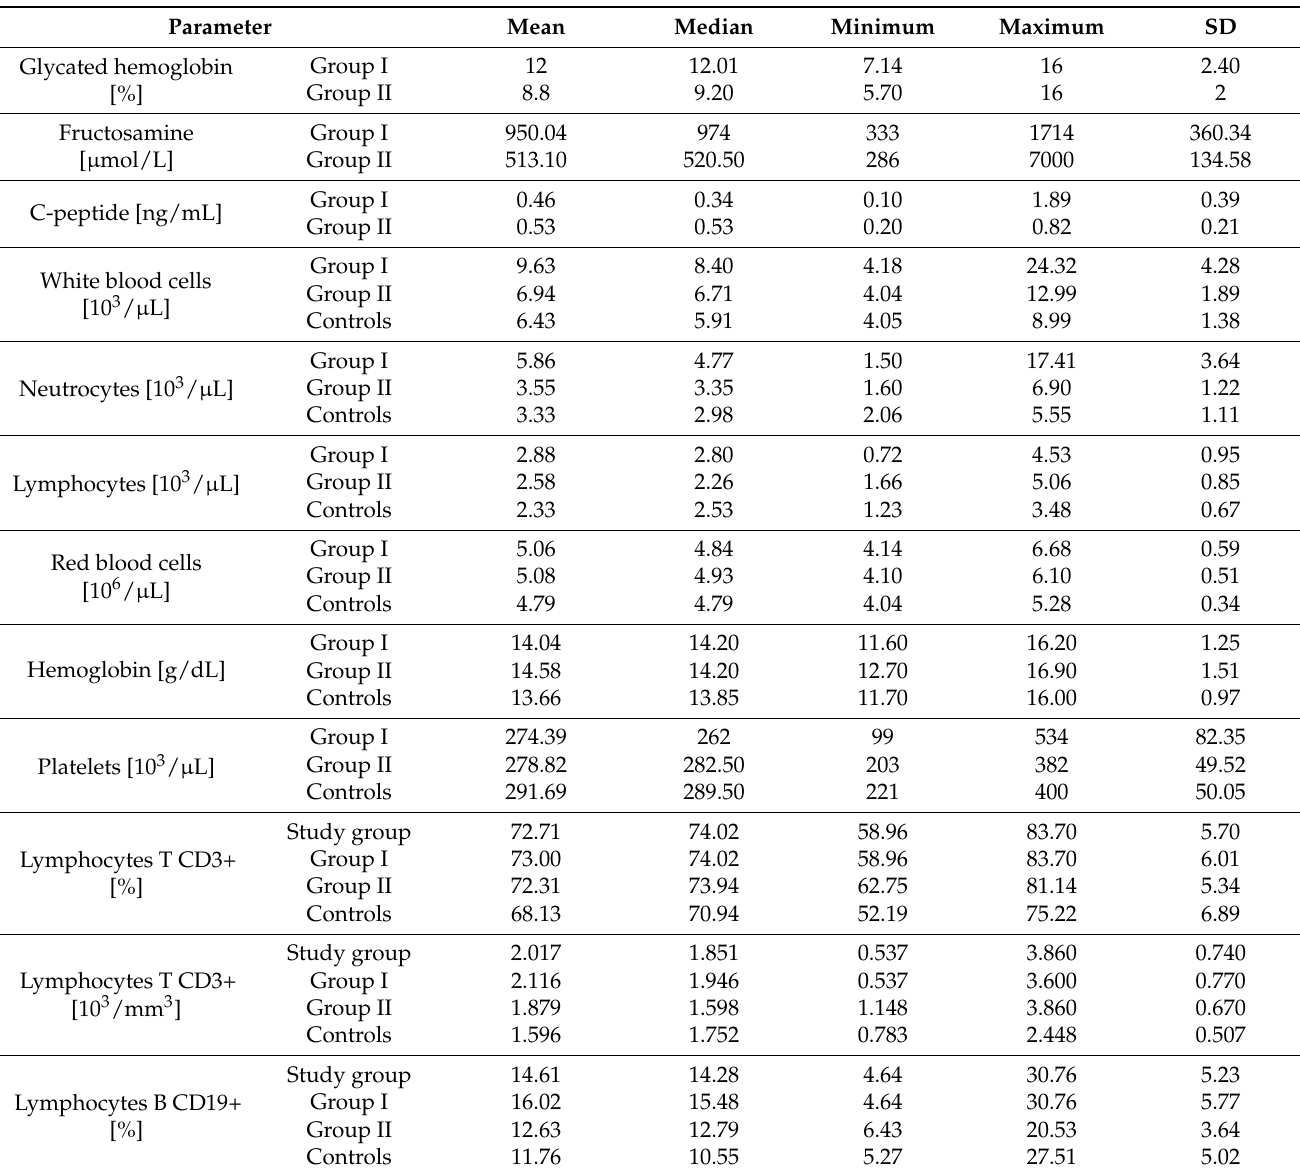
The results showing the percentage and absolute values of CD19+ B cells in the peripheral blood of patients with type 1 diabetes and in the control group are provided in Table 1. The conducted analysis showed a significantly higher number ( p = 0.015) of CD19+ B lymphocytes in the group of children with type 1 diabetes than in the control group. There was a significantly higher percentage ( p = 0.016) and higher number ( p = 0.003) of CD19+ B lymphocytes in the group of patients with newly diagnosed diabetes (<3 months from diagnosis) than in the control group. There was a higher percentage ( p = 0.019) and a higher number ( p = 0.019) of CD19+ B cells in children with type 1 diabetes for less than 3 months compared to chronic DM1 patients. Table 1. Basic characteristics of study and control